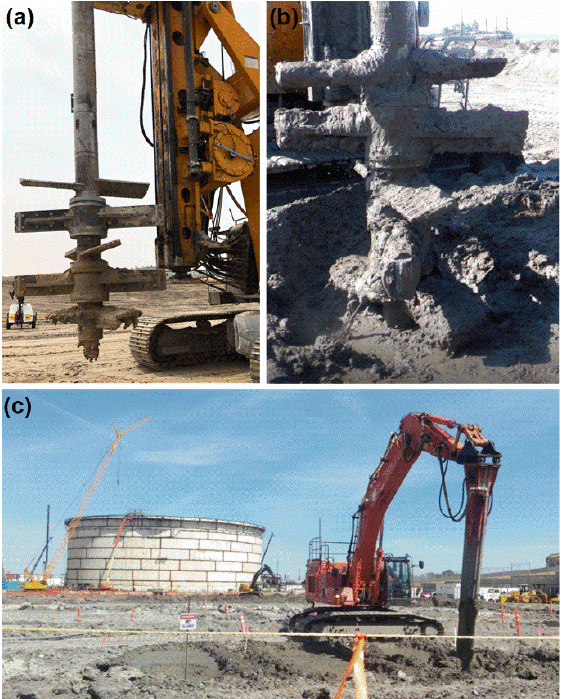
Figure 8. Construction of DSM columns with the wet mixing method: ( a ) before drilling and ( b ) retrieval and mixing, and ( c ) block construction by wet mixing.